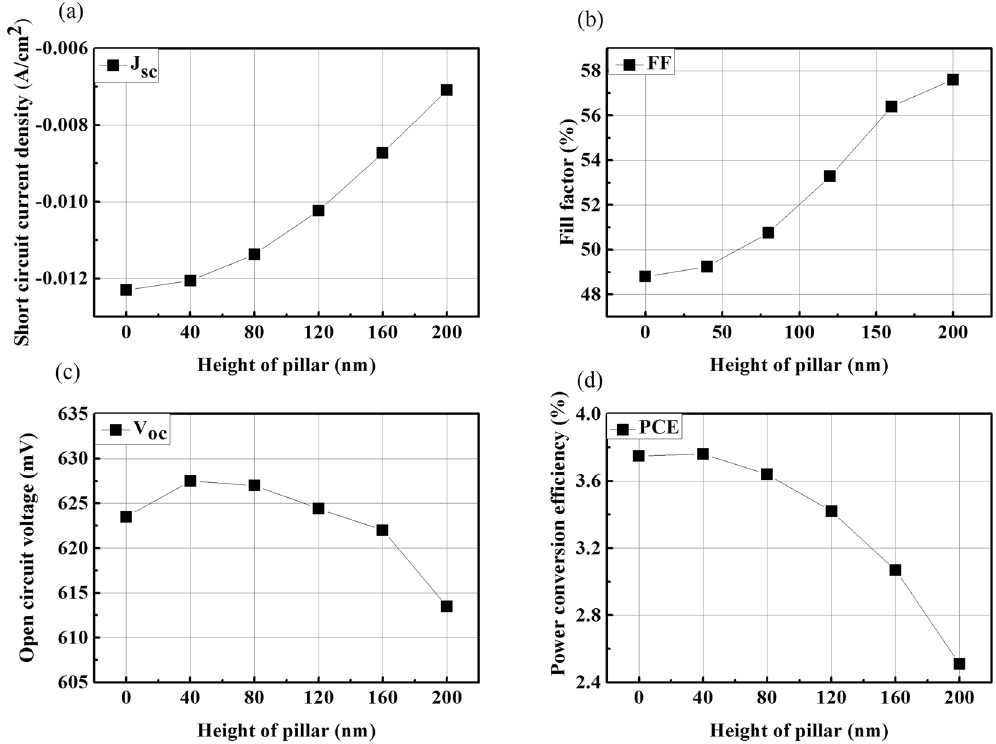
Figure 4. Numerical results for ( a ) the short circuit current density J sc , ( b ) the fill factor FF, ( c ) the open circuit voltage V oc , and ( d ) the overall power conversion efficiency PCE of the considered OSC as functions of varying pillar height. While the effect on V oc is limited, J sc decreases noticeably for higher pillars. This decrease is addressed to the fact that in our simulations the active layer thickness (and not volume) is kept constant, which reduces the active layer volume of the absorbing material with increasing pillar height. However, the PCE reduction is not consistent with the lower absorption, which can be understood by considering the improved collection efficiency and thus, FF enhancement as a function of pillar